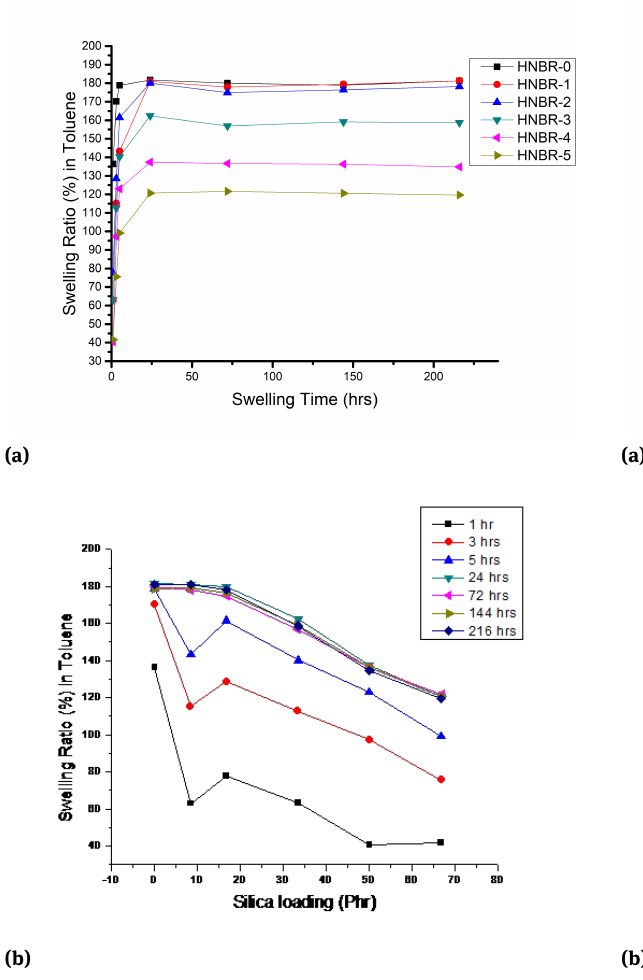
Figure 4: Swelling behavior of HNBR in water (a) swelling ratio vs. swelling time (b) Swelling ratio vs. silica